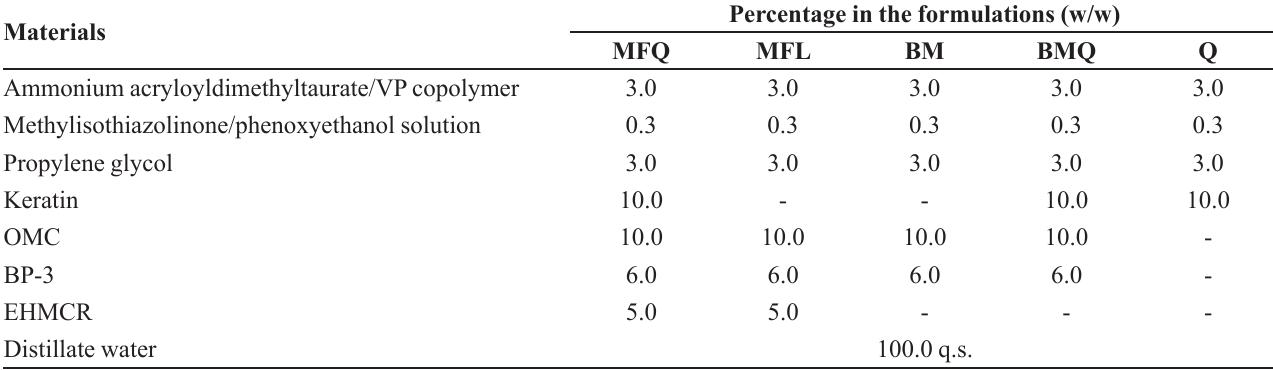
TABLE I - Formulations developed: MFQ, MFL, BM, BMQ and Q